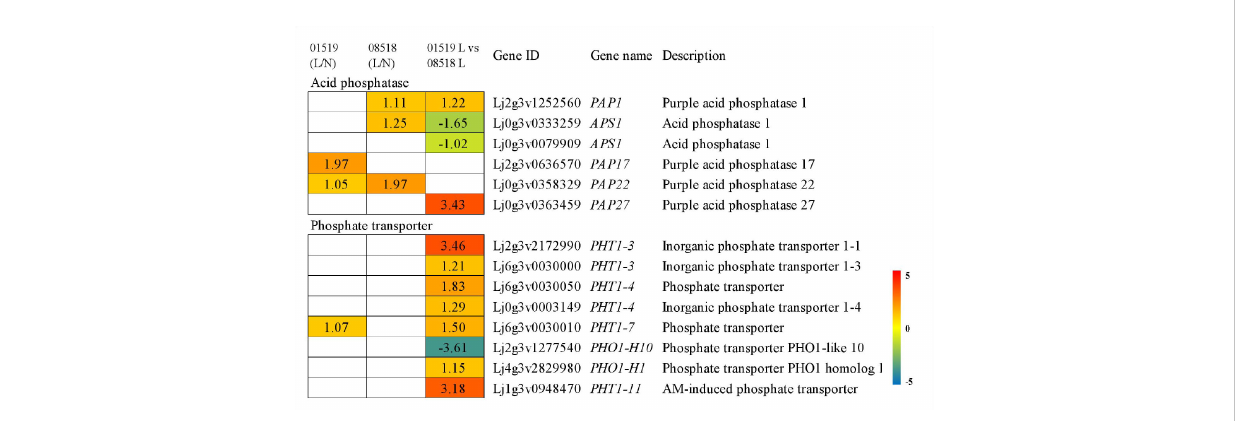
FIGURE 4 Acid phosphatase and phosphate transporter genes identi fi ed in the RNA-seq analysis that showed changes in expression during low-P stress. Log 2 (fold-changes) of the comparisons are shown by the numbers in the gray rectangles. The comparisons show that each of the genes in the picture is signi fi cantly differentially